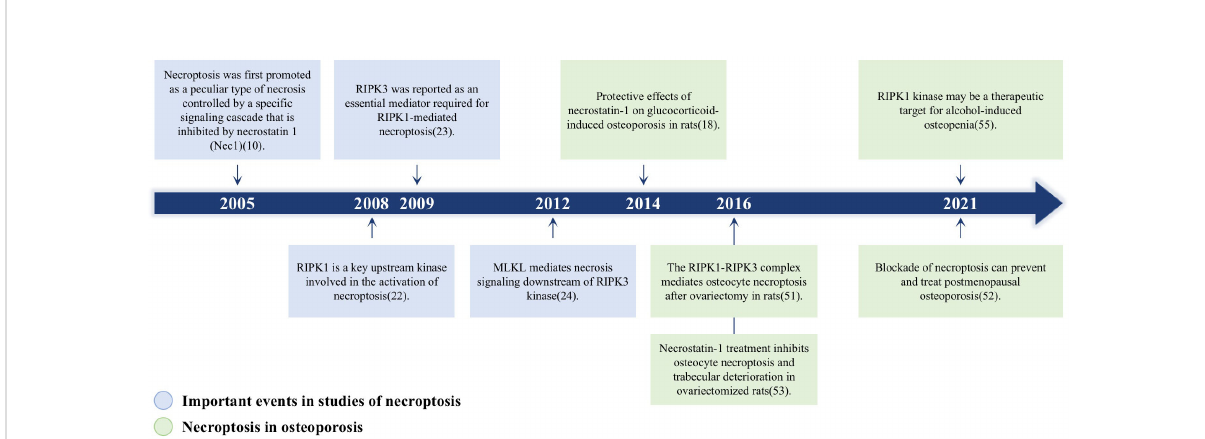
FIGURE 1 A timeline of the momentous events for necroptosis and its role in osteoporosis. Blue boxes highlight the major fi ndings in the discovery of necroptosis signaling pathway; Green boxes represent the researches about the role of necroptosis in